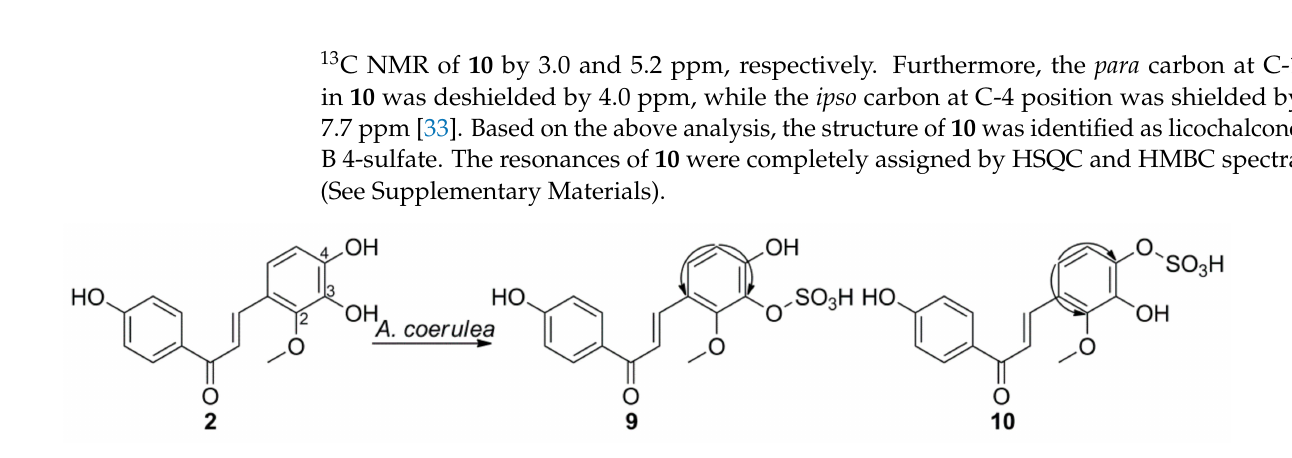
Figure 4. Microbial transformation of 2 by A. coerulea . Selected HMBC correlations ( 1 H → 13 C) of metabolites 9 and 10 are indicated by arrows.